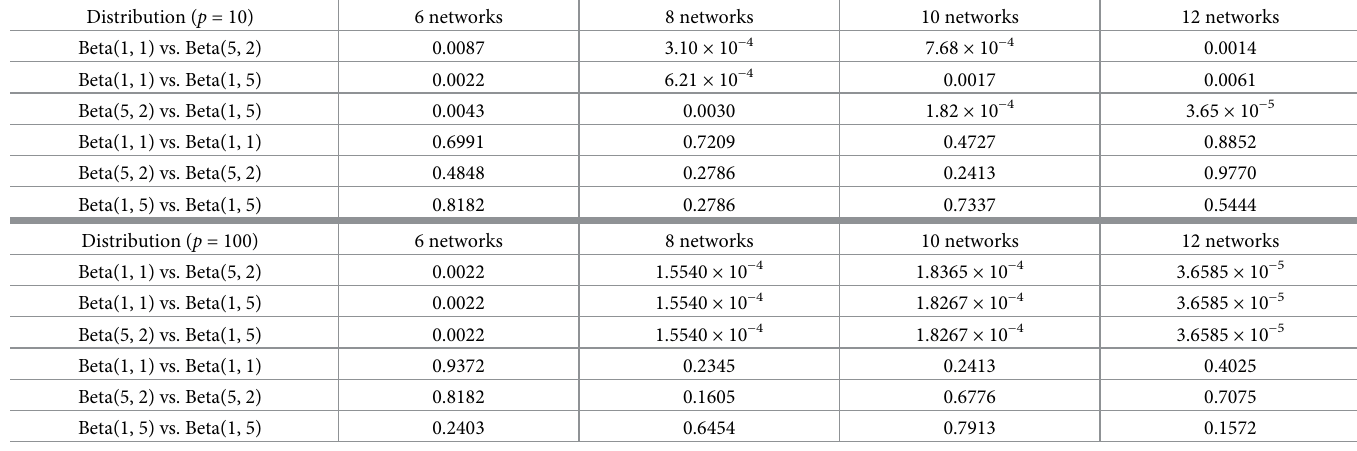
Table 3. The average p -values obtained using Wilcoxon rank sum test on the areas under β 0 curves for small ( p = 10) and large ( p = 100) network settings. Here, the columns 6 networks, 8 networks, 10 networks, and 12 networks indicate the number of networks that we considered for both the groups. The p -values smaller than 0.01 indicate that our method can identify network differences at a 99% confidence